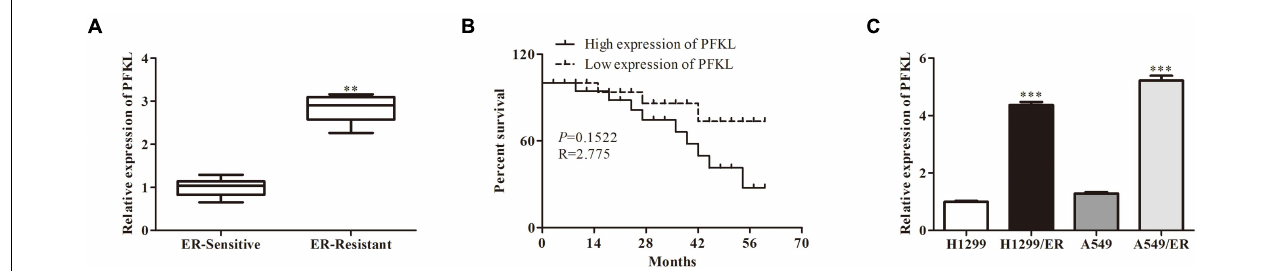
FIGURE 4 | Liver-type phosphofructokinase was upregulated in ER-resistant cells and tissues. (A) The relative expression of PFKL was determined by Western blot in ER-sensitive and ER-resistant tissues. (B) The survival rate of patients with different levels of PFKL. (C) The relative expression of PFKL was determined by Western blot in various lung cancer cell lines. Data were shown as mean ± SD. ∗∗ p < 0.01; ∗∗∗ p <